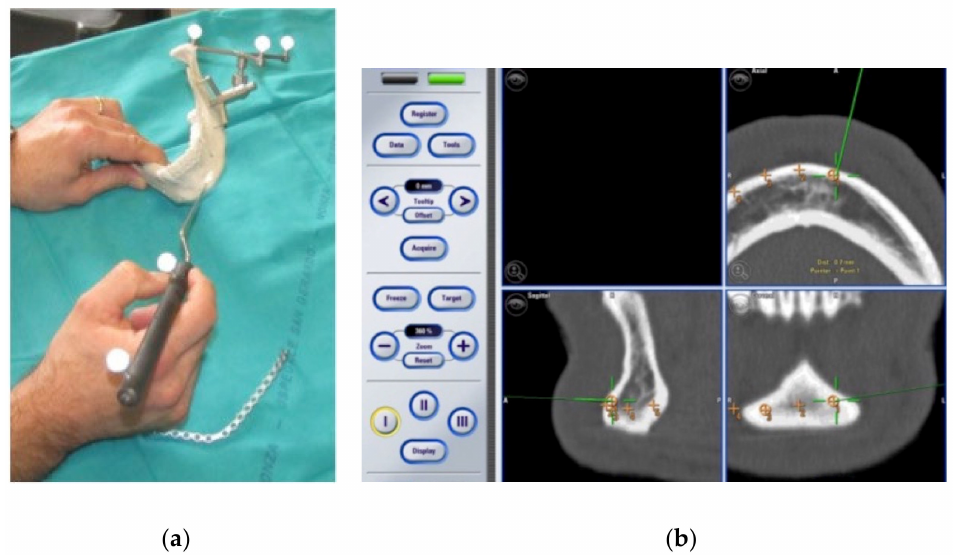
Figure 4. ( a , b ): Through preoperative surgical navigation of the 3D model, the position of the screw holes is